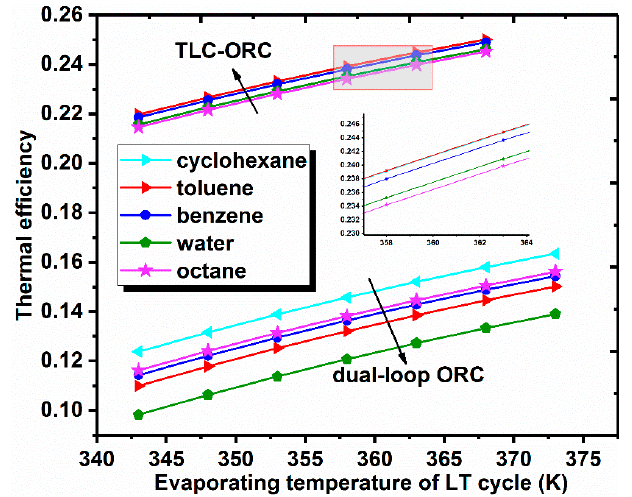
Figure 9. Comparison of thermal efficiency between the two configurations under different LT cycle evaporating temperature.